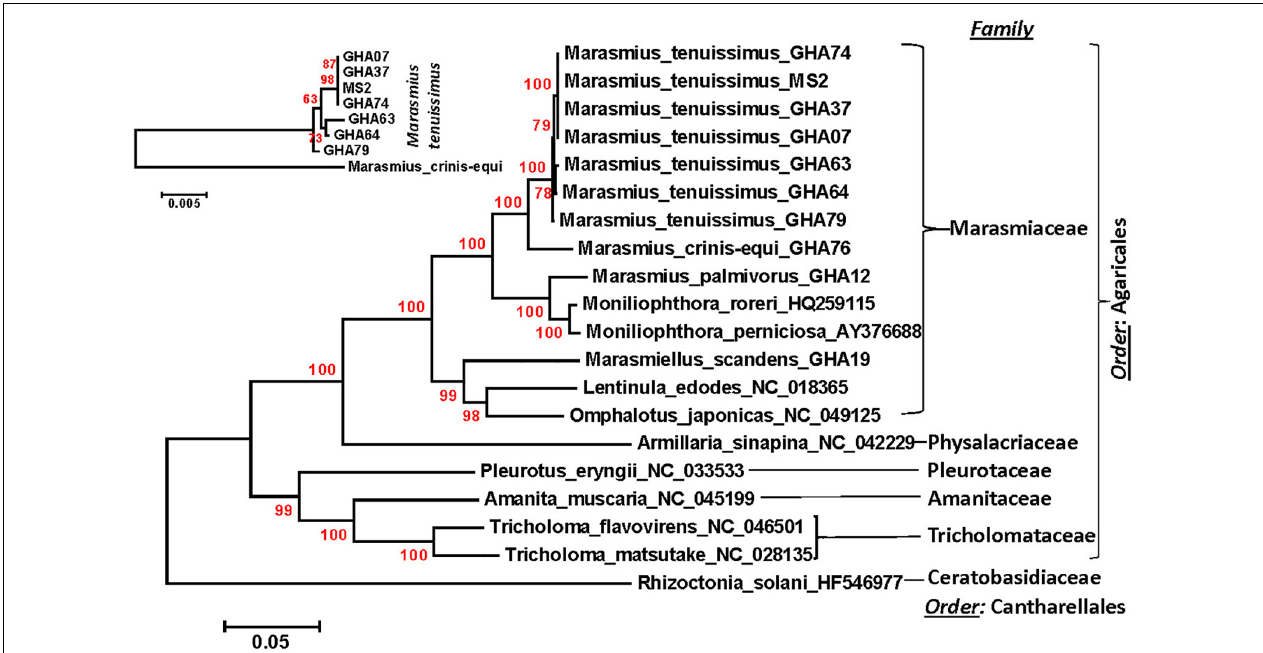
FIGURE 4 | Molecular phylogenetic analysis of four cacao thread blight associated pathogens from Ghana ( M. tenuissimus , M. palmivorus , M. crinis-equi , Mar. scandens ) and the Western hemisphere frosty pod rot ( Mon. roreri ) and witches’ broom ( Mon. perniciosa ) pathogens of cacao along with some other members of Marasmiaceae and Agaricales . The Rhizoctonia solani was used as an outgroup. The analysis was based on the amino-acid sequences of 14 conserved mitochondrial proteins with 3,154 distinct alignment positions and 1,000 rapid bootstrap inferences. Sequences were combined and aligned using ClustalW2 tool under default setting and the phylogenetic tree was reconstructed using the Maximum Likelihood method. The tree is drawn to scale, with branch lengths measured in the number of substitutions per site. Analyses were conducted in MEGA6 (Tamura et al., 2013). The analysis was re-run with seven M. tenuissimus and M. crinis-equi as an